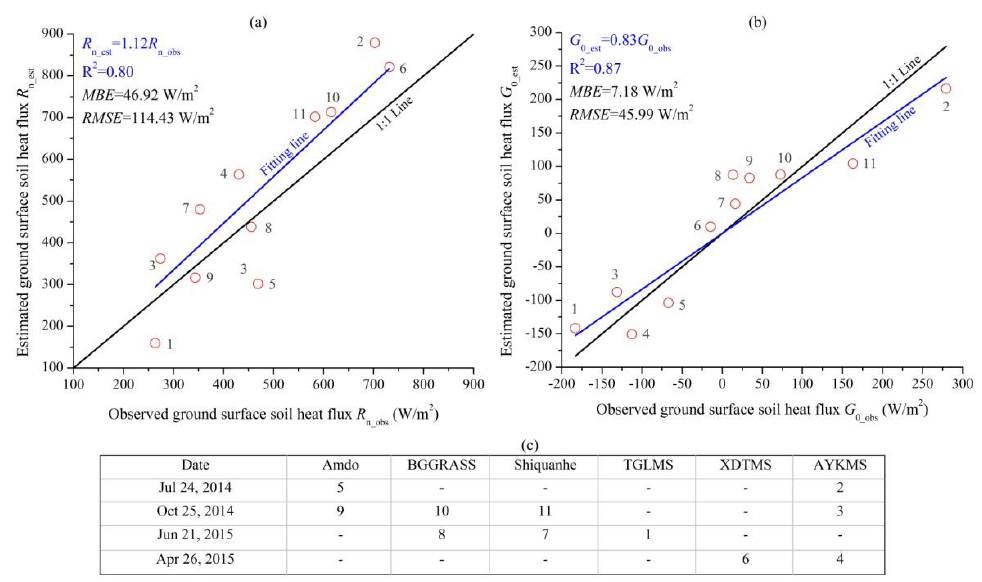
Table 4. VR accuracy , the ultimate sensitivity coefficient, of the scheme Choudhury.